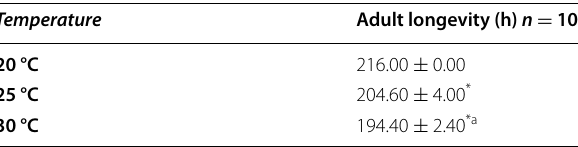
Table 4 Effect of different constant temperatures on the average of Chrysomya albiceps adult longevity (h) at different constant temperatures